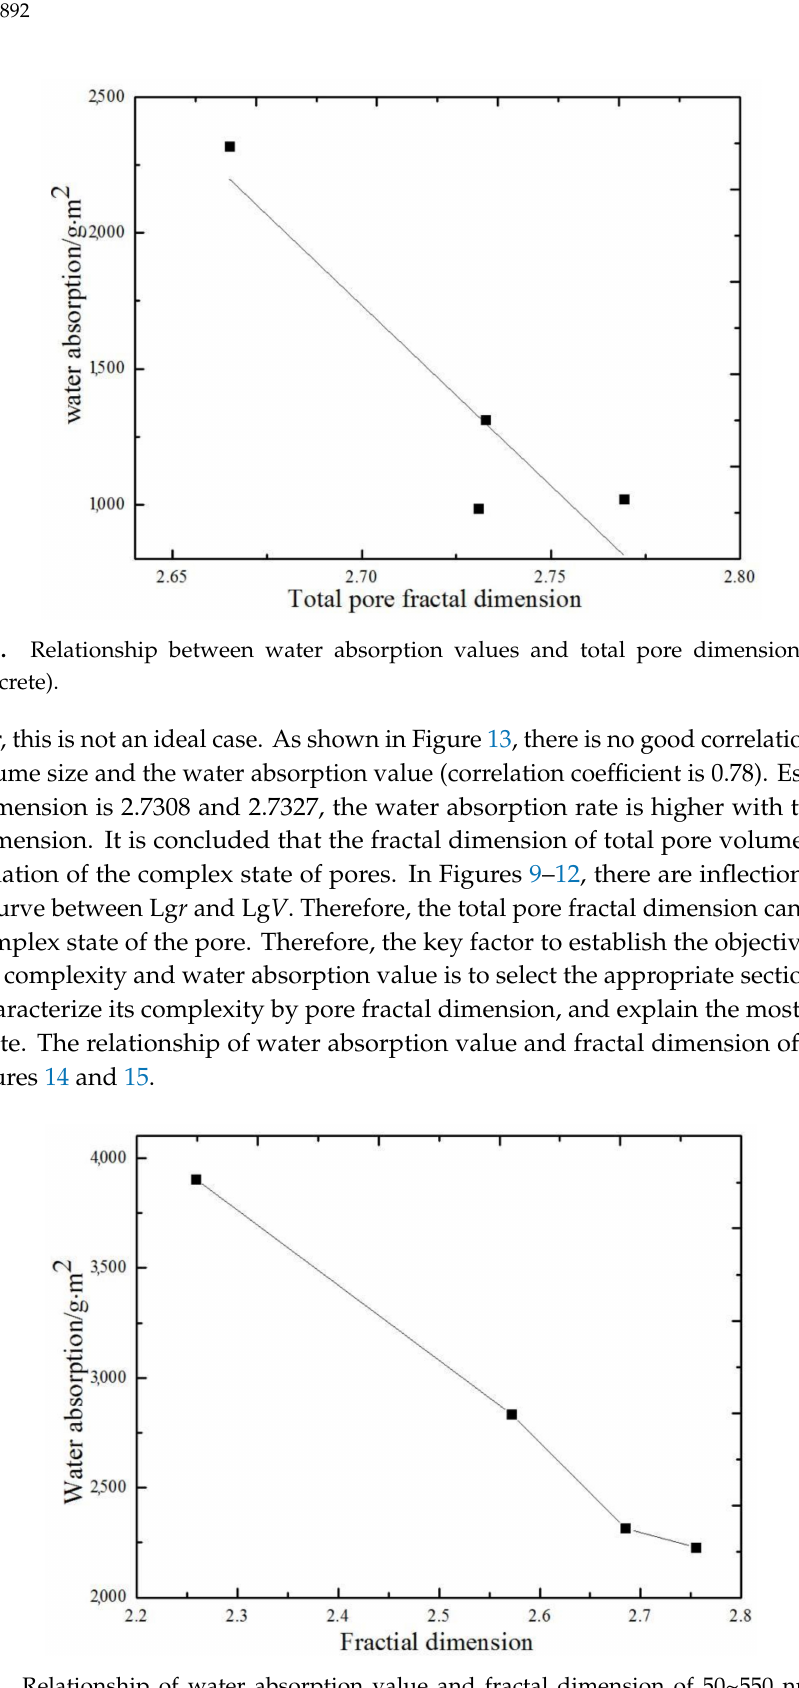
Figure 14. Relationship of water absorption value and fractal dimension of 50~550 nm (7 days cured